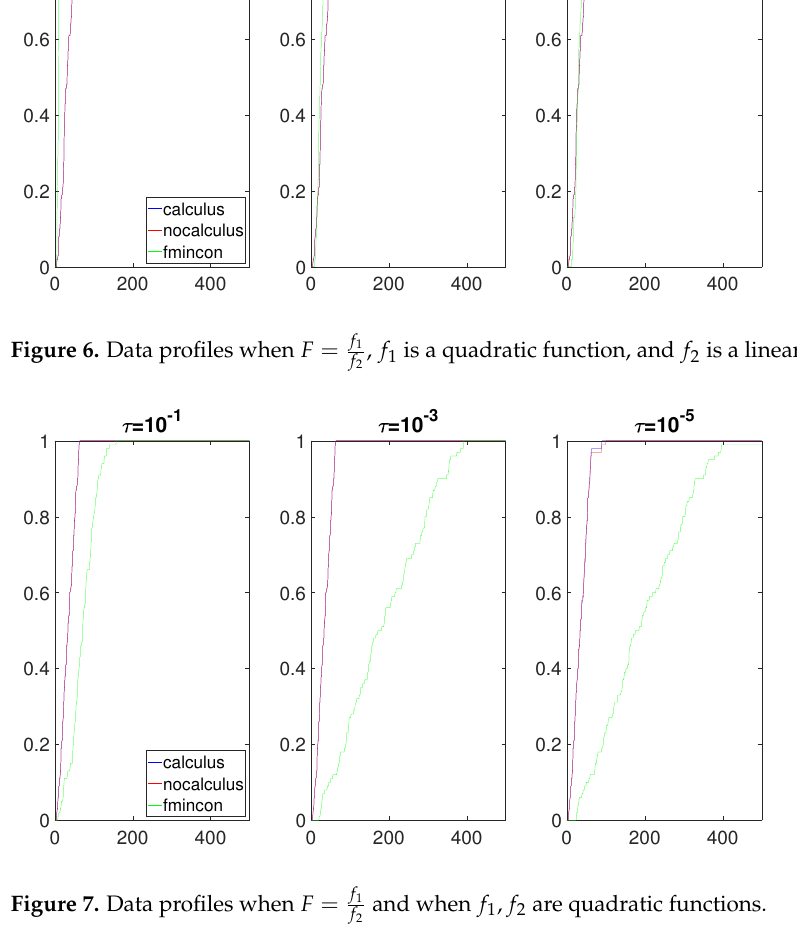
Figure 7. Data profiles when F = f 1 and when f 1 , f 2 are quadratic functions. f 2 Last, we present the data profiles for the quotient rule as described in Section 3.3.3. The following 12 data profiles were obtained (Figures 8–11).